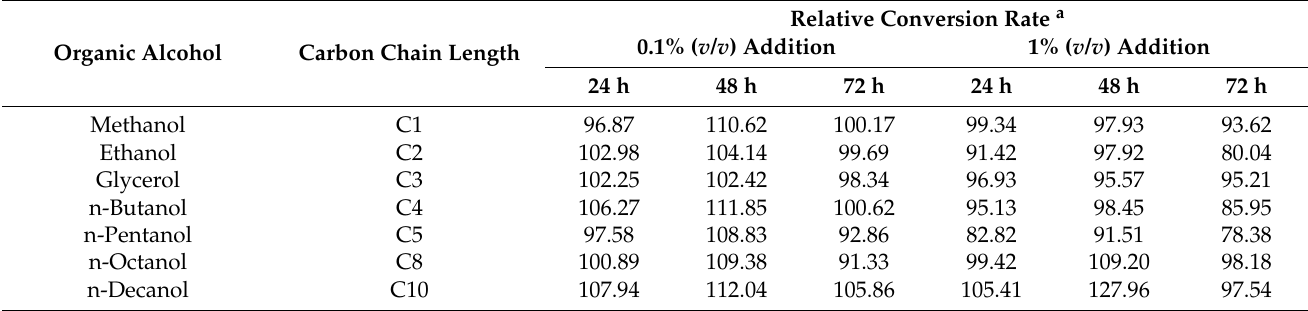
Table 2. Effects of different OAs on enzymatic hydrolysis of